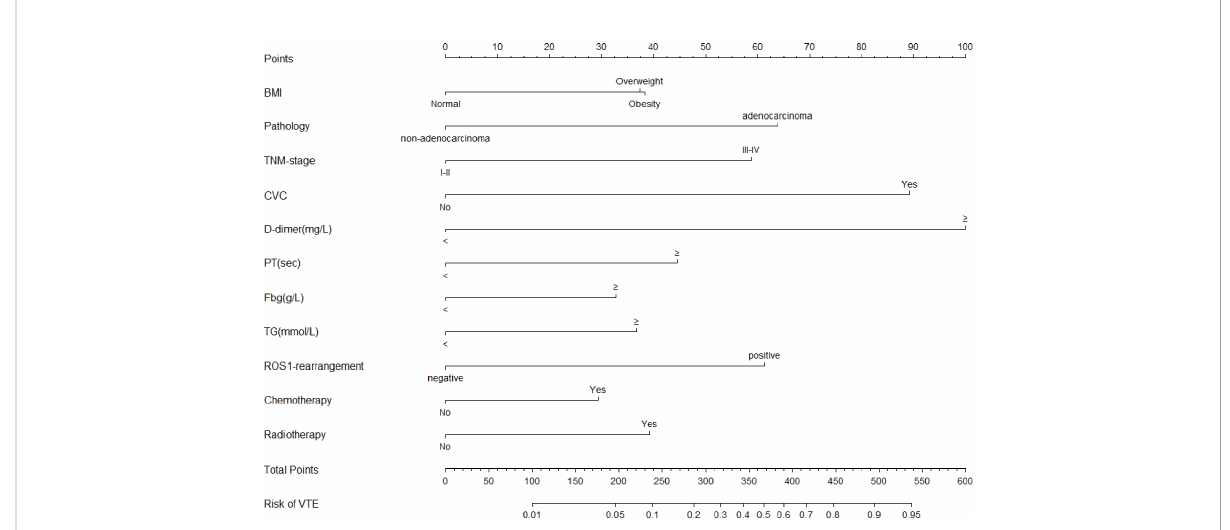
FIGURE 2 The Nomogram model for prediction of VTE in hospitalized patients with lung cancer. VTE, venous thromboembolism; BMI, Body Mass Index; CVC, central venous catheter; PT, prothrombin time; Fbg, fi brinogen; TG,